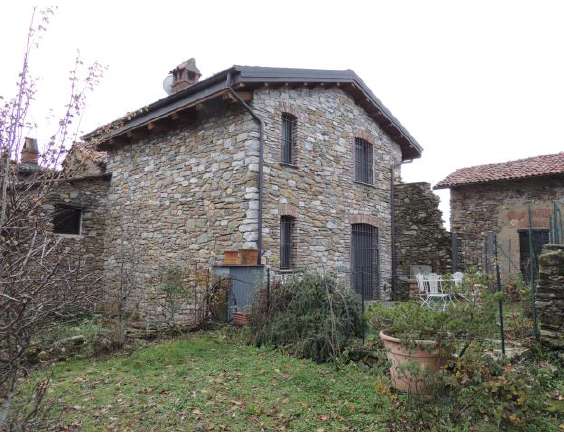
Figure 7. Building E - Balcony with reinforced concrete structure (credits Fabio Fratini).